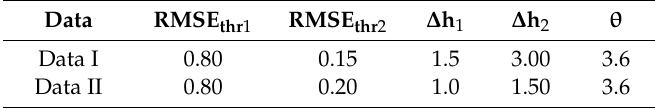
Table 3. Parameters used for classification pole-like objects